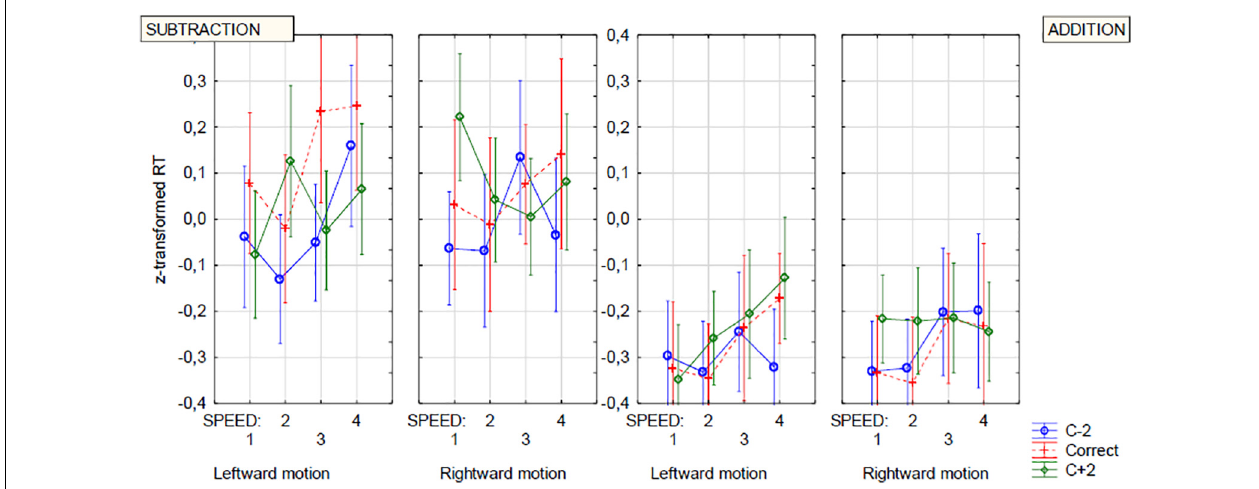
FIGURE 5 | Reaction times. Four-way interaction of OPERATION , OUTCOME OPTION , VELOCITY (Speed), and M OVEMENT D IRECTION . Blue line, c–2 option; Green line, c + 2 option; correct option (c) additionally plotted with red dashed line.